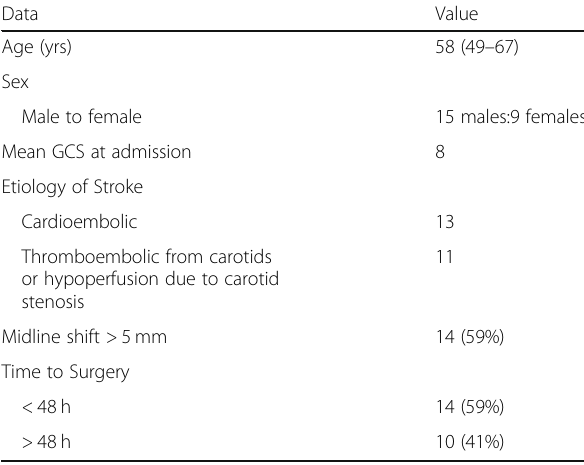
Table 1 Patient characteristics